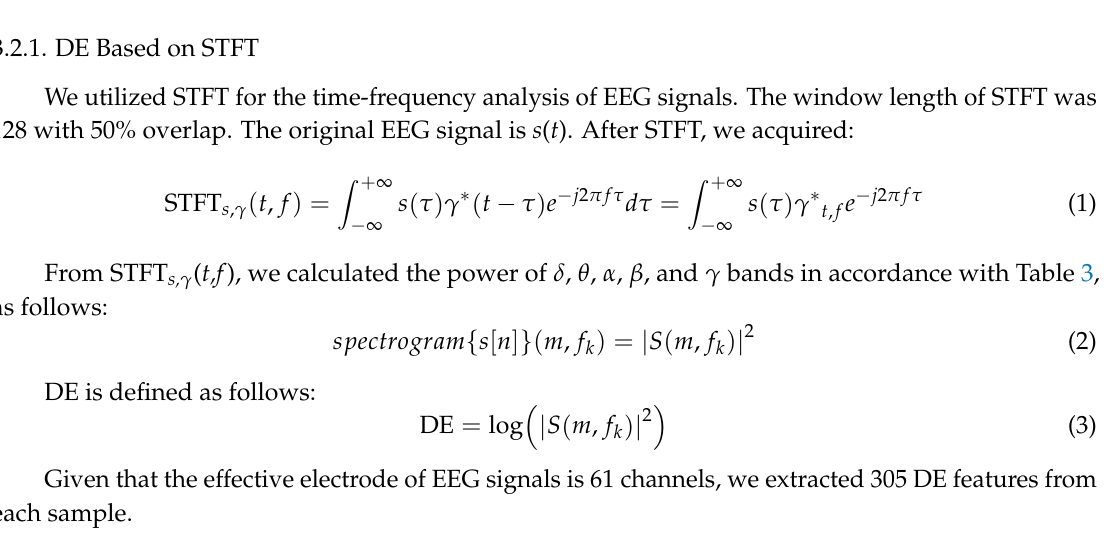
Figure 7. Feature extraction process.